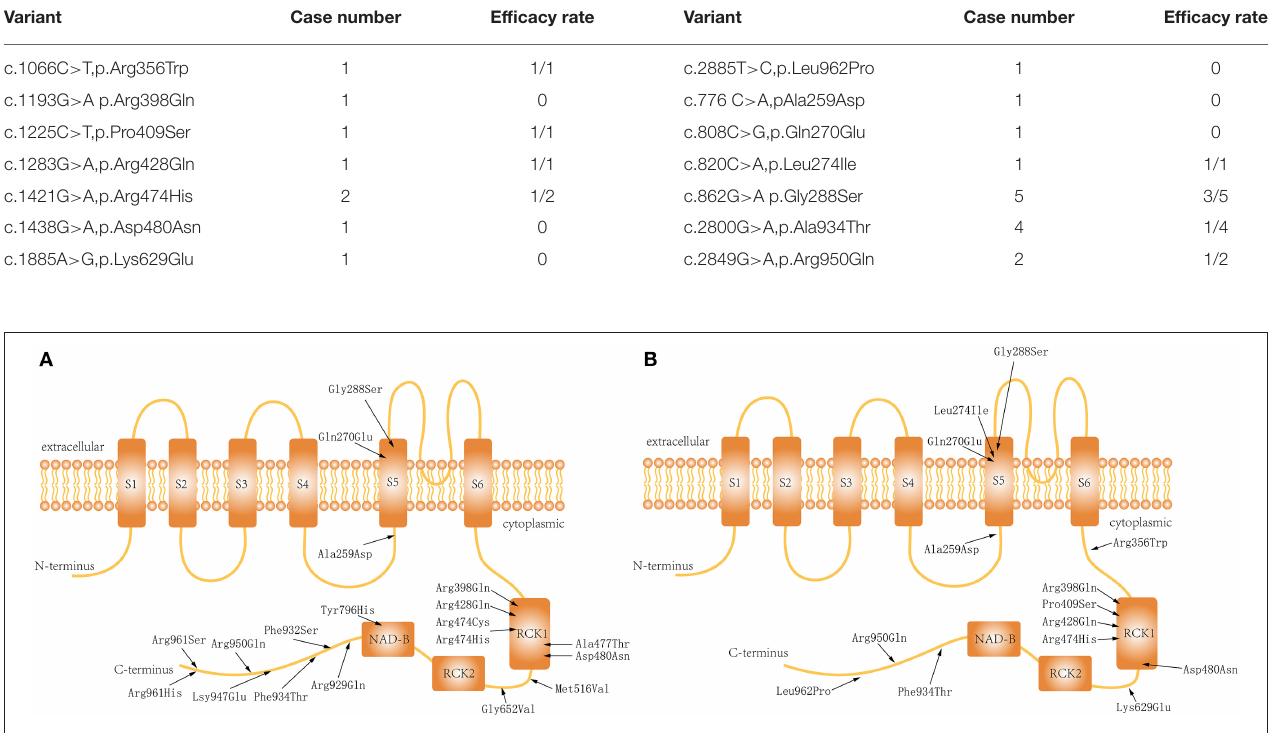
FIGURE 1 | Distribution of the variations in the Slo2.2 channel: (A) Patients who received quinidine treatment. (B) Patients who underwent ketogenic diet therapy.